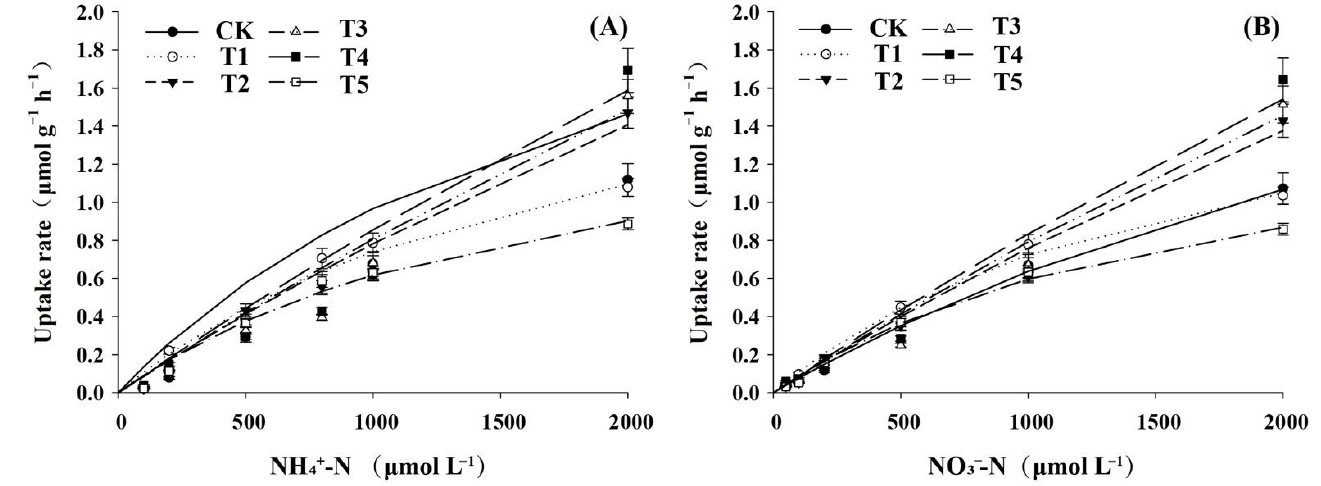
Figure 8. NH 4+ and NO 3 − uptake rates of pecan under varying NH 4+ :NO 3 − ratios. ( A ). NH 4+ uptake rates of pecan under varying NH 4+ :NO 3 − ratios ( B ). NO 3 − uptake rates of pecan under varying NH 4+ :NO 3 − ratios.